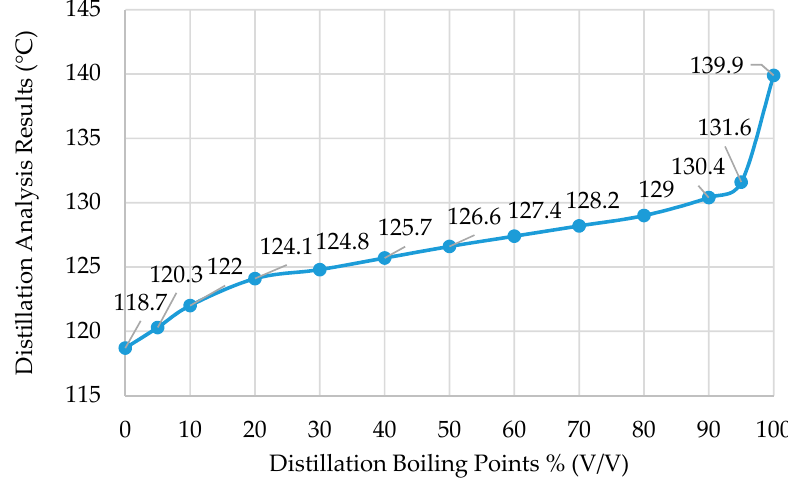
Figure 1. Results of distillation analysis.